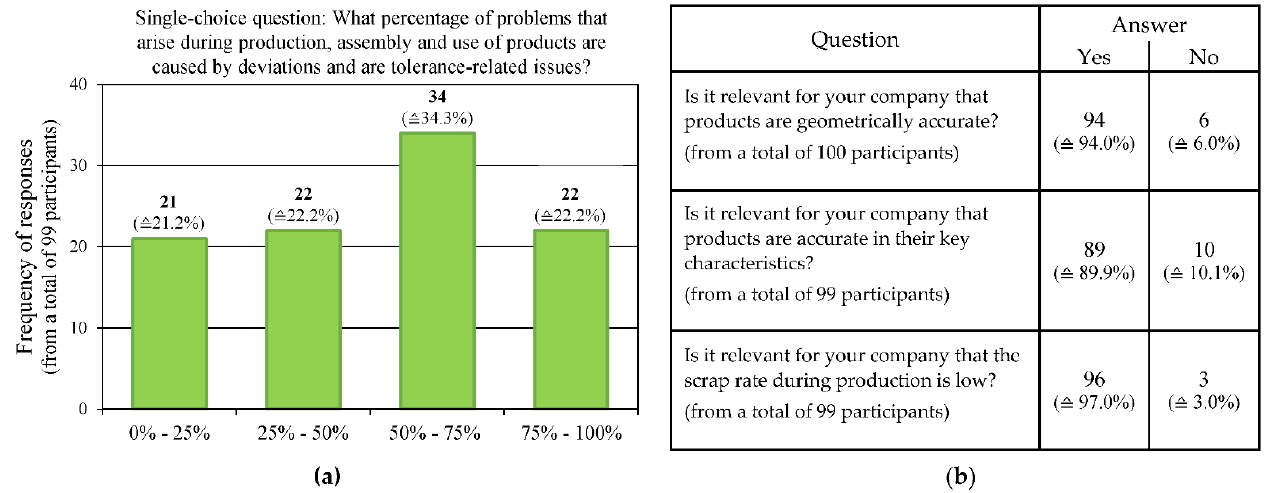
Figure 3. ( a ) Response of 99 participants to the (single–choice) question: “What percentage of problems that arise during production, assembly and use of products are caused by deviations and are tolerance-related issues?”; ( b ) response of participants to selected (single–choice) questions.